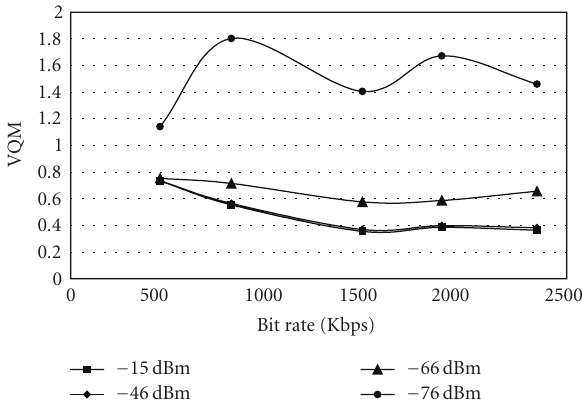
Figure 5: PQoS varying the quality link and the bit rate.